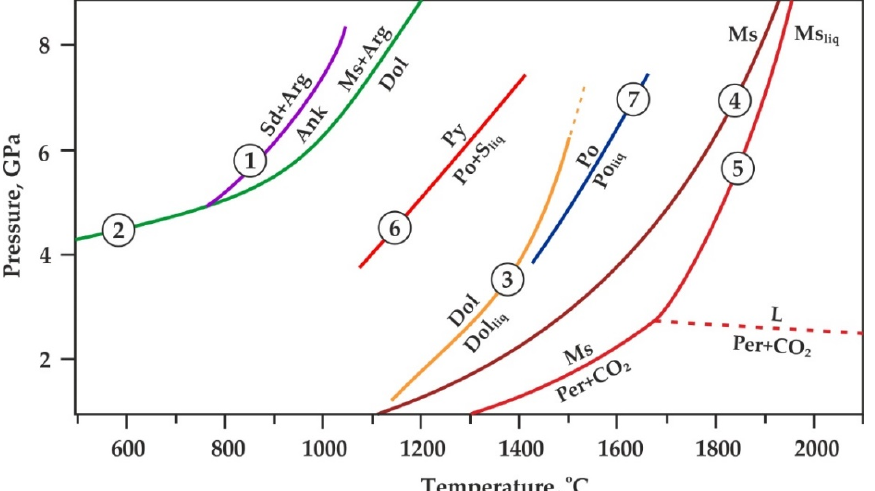
Figure 1. Experimentally determined parameters of melting and decomposition of Mg,Ca,Fe carbonates and iron sulfides: 1—siderite + aragonite = ankerite [31]; 2—magnesite + aragonite = dolomite [31]; 3—dolomite melting [32]; 4,5—magnesite melting and decomposition [33]; 6,7—pyrite and pyrrhotite melting curves [34]. Dotted line denotes P–T position of reaction of periclase + CO 2 = MgCO 3 melt [33].